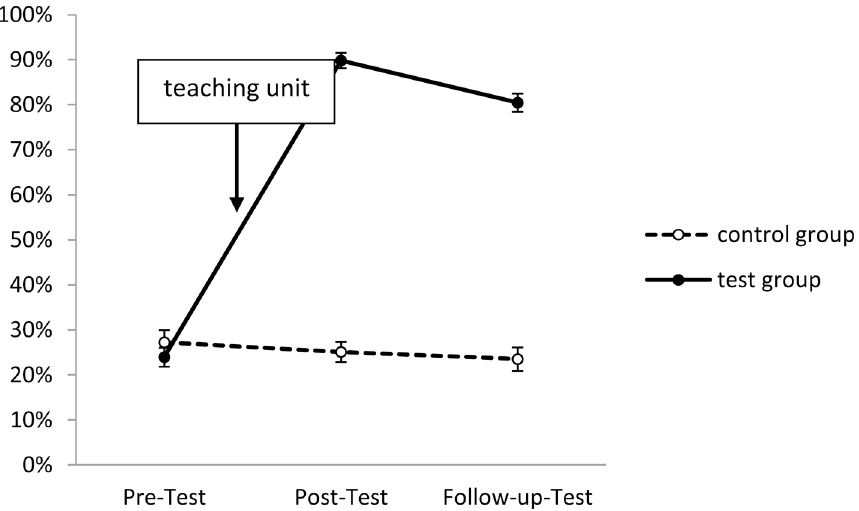
Fig 3. Development of medical knowledge in test and control group (domain 3). Shown are solution rates (mean of all medical knowledge-related items). For descriptives see S1 Table.